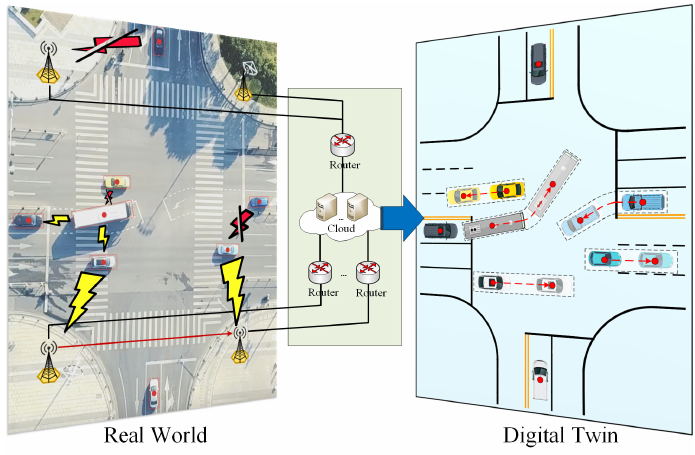
Figure 1. Illustration of mapping the real-world intersection to the DT intersection via IoV communication.